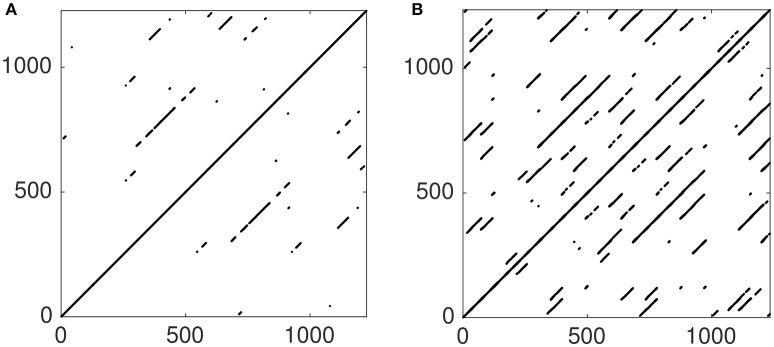
Multivariate JPR obtained by joining the individual RPs from Figures 3H–J (A). MdRP from Figure 3K (B). The plots convey a similar qualitative picture of the dynamics of the Lorenz system, with the main difference that the JRP has fewer points and fewer diagonal structures than the MdRP.